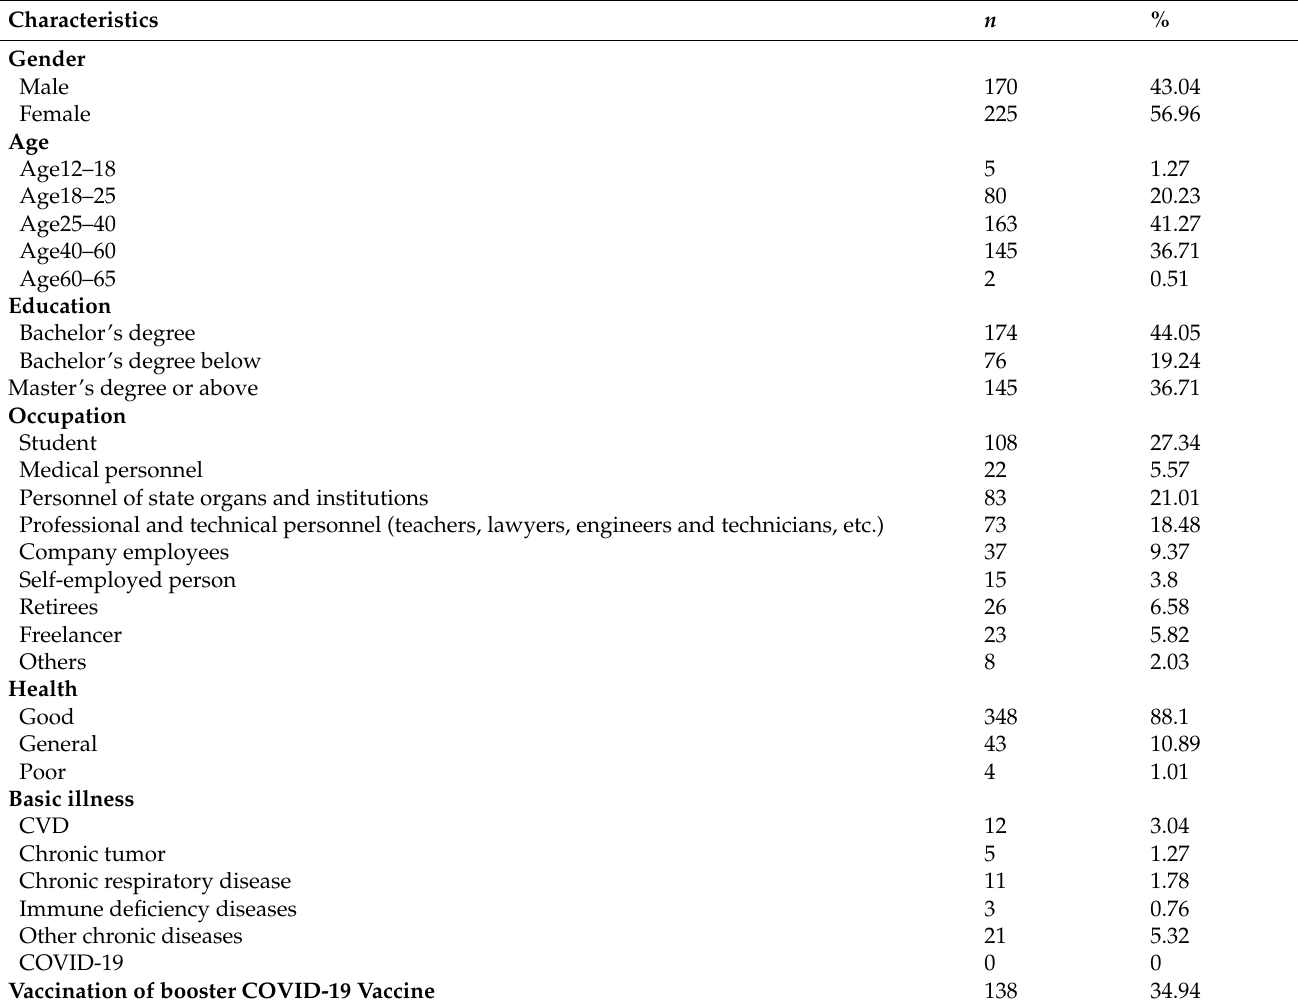
Table 1. Characteristics of the opinion poll samples ( n =